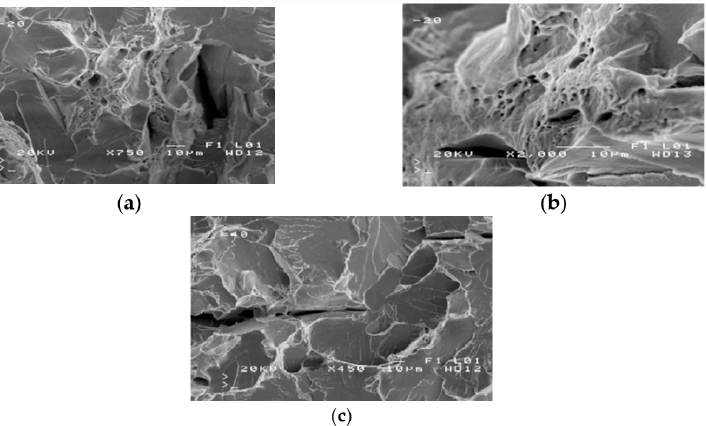
Figure 9. Scanning electron microscope (SEM) views: ( a ) a fracture with a mixed structure.; ( b ) plastic fracture with a crater-like structure; and ( c ) brittle fracture obtained at − 40 ◦ C (handy-size bulk carrier 30182